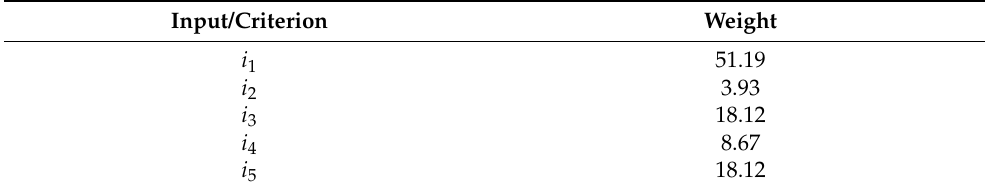
Table 5. Input weights for z =